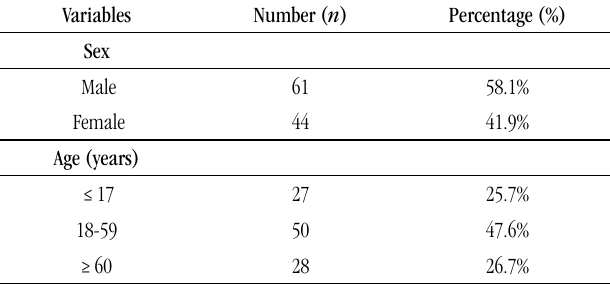
tABLE 2 – Demographic data on patients admitted to the intensive care